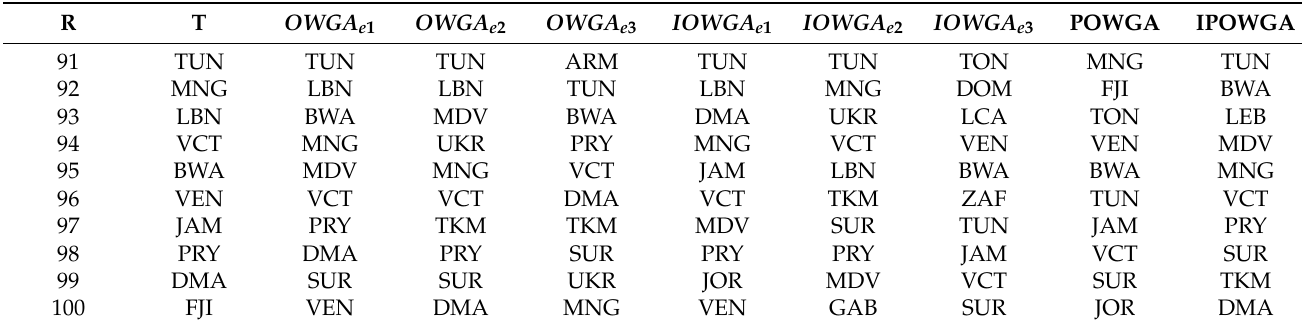
Table 4. Middle 10